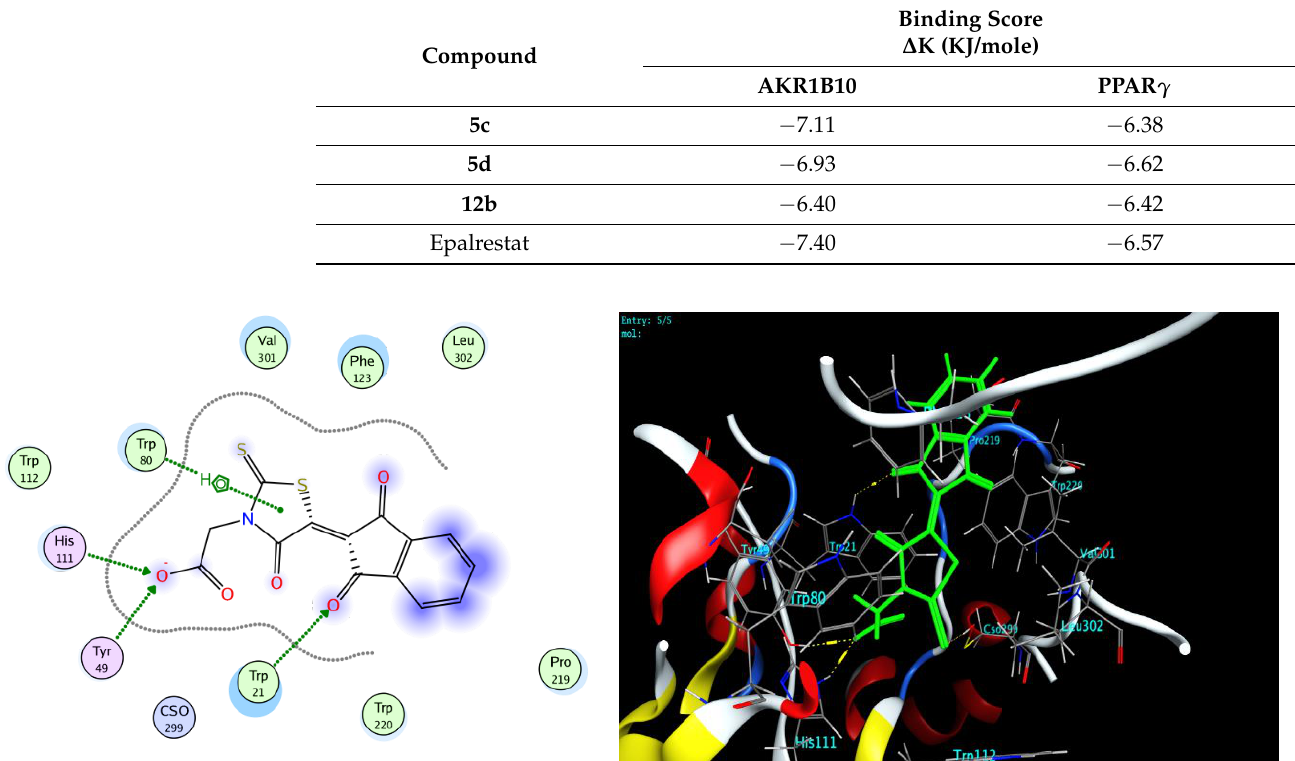
Table 5. Binding score of compounds 5c,d, 12b to AKR1B10 and PPAR γ .